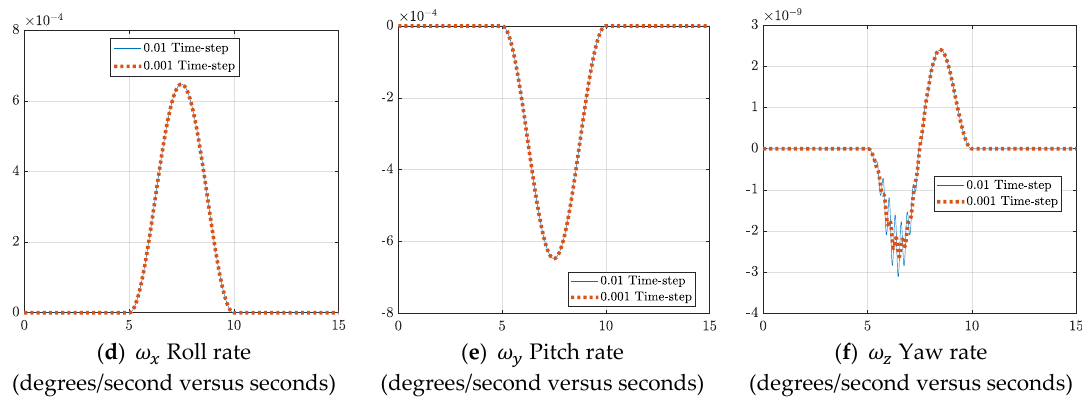
Figure 5. Time-step analysis comparing θ actual − θ desired and ω actual − ω desired errors.